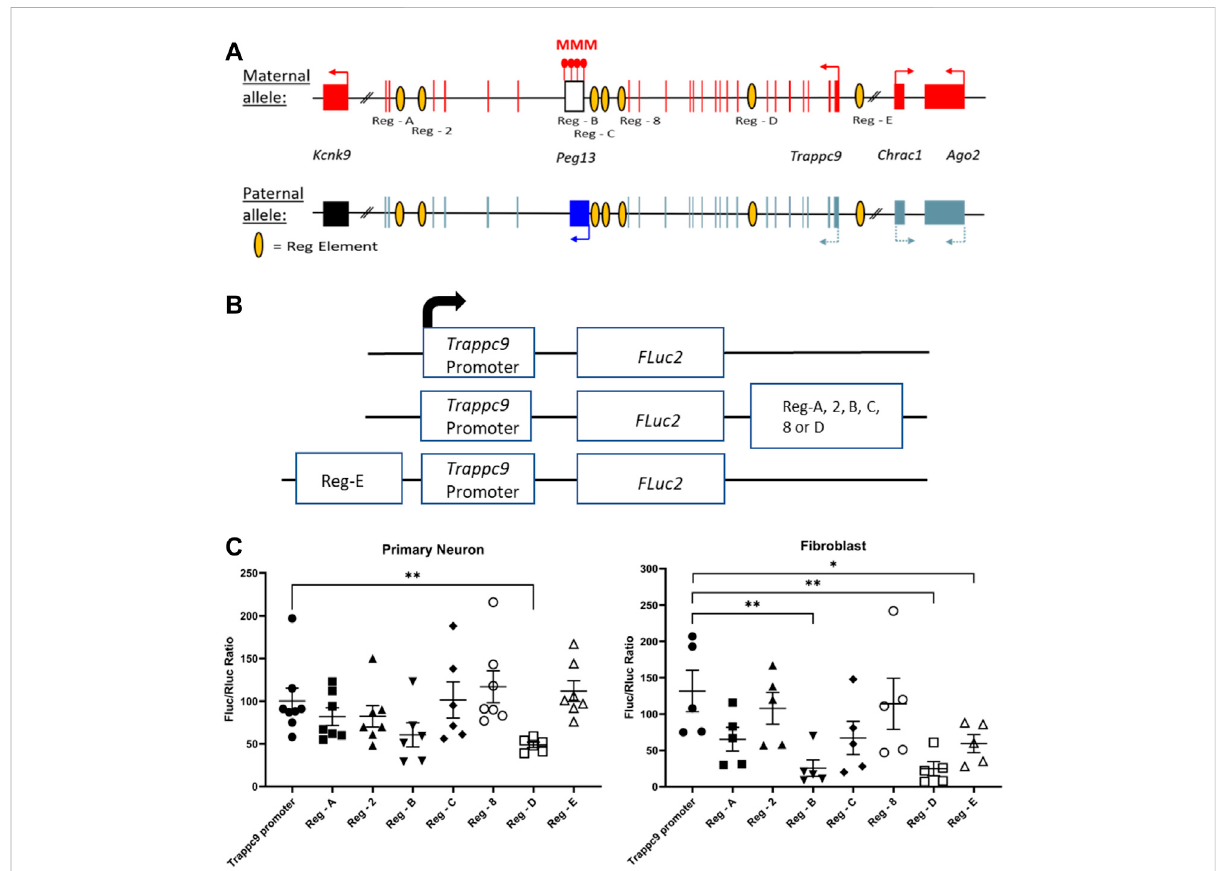
FIGURE 6 Promoter-reportergeneassaysindicatesilencerelementsfor Trappc9 . (A) Schemeofthemurine Peg13 — Kcnk9 — Trappc9 clusterofimprinted genes. For Trappc9 all introns are shown; for Chrac1 , Ago2 and Kcnk9 introns have been omitted. Promoters, transcriptional activity and directions areindicatedbyarrows.Alsoindicatedaretheapproximatelocationsofthecandidateregulatoryelements(listedinSupplementaryFigureS6)across Trappc9 introns. Not to scale. (B) Schematic of the promoter/enhancer constructs used for transfection of primary cells. Enhancers were positioned downstream or upstream of the promoter-reporter gene cassette depending on their relative locations within the Trappc9 gene and in the same orientation. (C) Reporter gene activity of the constructs in cultures of primary hippocampal neurons from newborn mice and primary embryonic fi broblasts. Normalized activity of Fire fl y luciferase (FLuc) to co-transfected Renilla luciferase (RLuc) is shown. Mean values ± S.E.M. are indicated. * p ≤ 0.05; ** p ≤